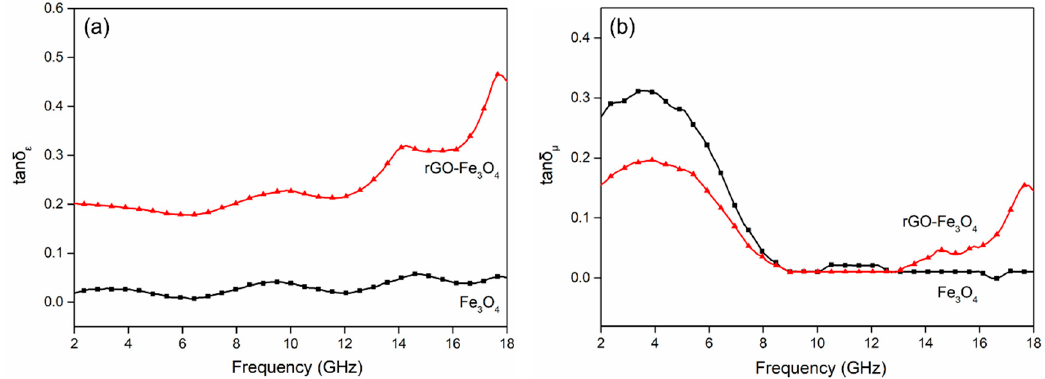
Figure 7. Plots of dielectric loss tangent ( tan δ ε ) ( a ) and magnetic loss tangent ( tan δ µ ) ( b ) for Fe 3 O 4 and rGO–Fe 3 O 4 .